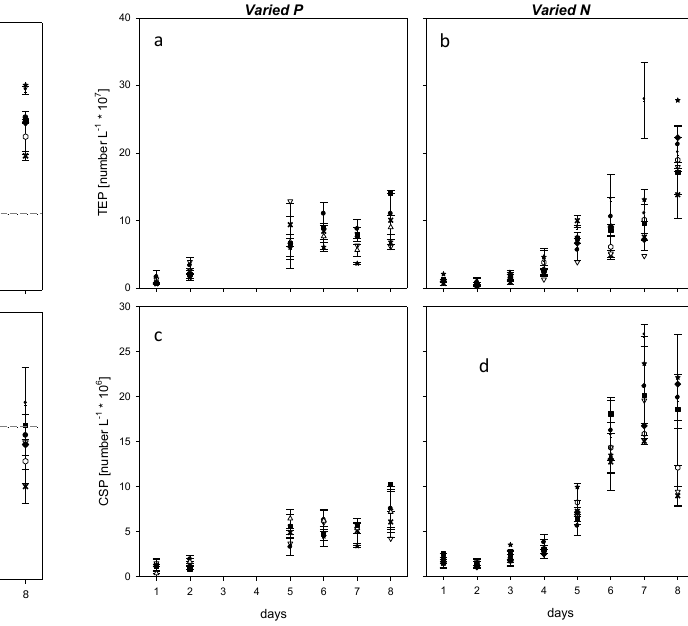
Figure 4. Temporal changes in the total numerical abundance of transparent exopolymer particles (TEP; a , b ) and of Coomassie stainable particles (CSP; c , d ) during Varied P (a, c) and Varied N (b, d) . For treatments with identical nutrient supply, average val- ues are given ± 1 standard deviation (error bars). The dashed line visualizes the zero value; symbols as in Table